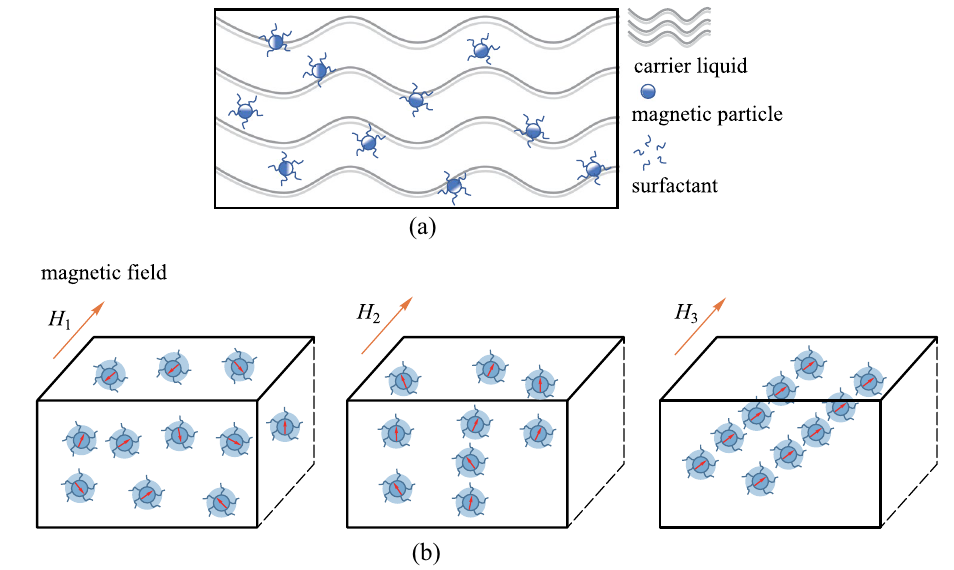
Fig. 13 a Schematic diagram of the composition of magnetic fluid. b Variation of magnetic fluid nanoparticles under different magnetic field intensities (magnetic field intensity: H 3 > H 2 > H 1